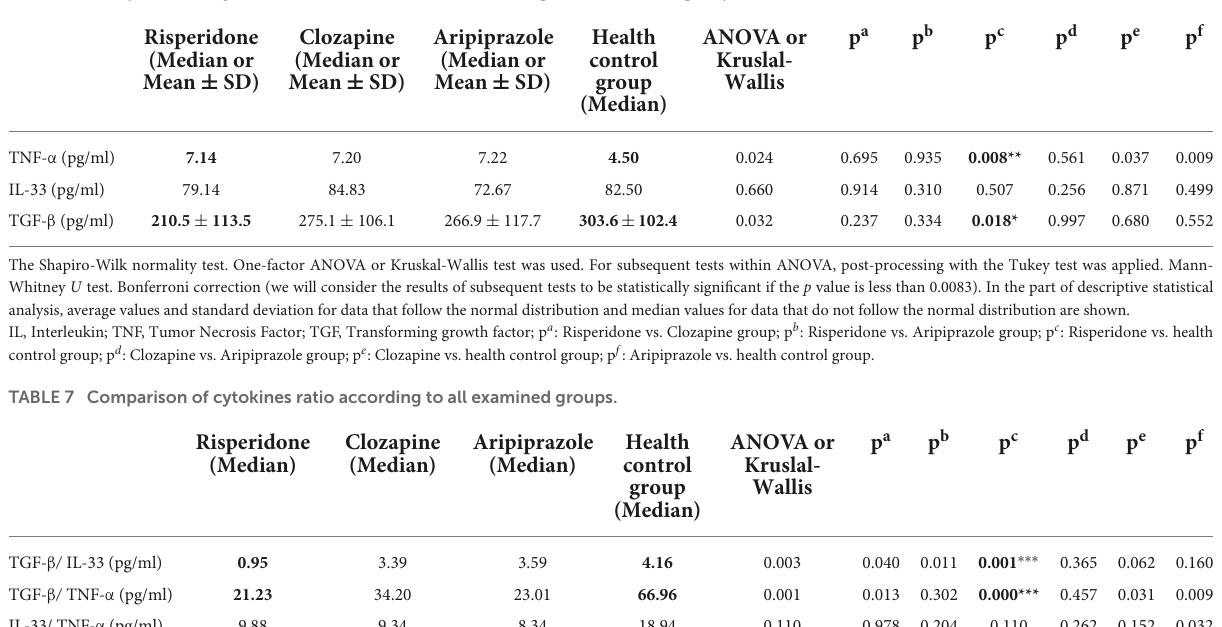
The Shapiro-Wilk normality test. Pearson’s correlation coefficient or Spearman’s correlation coefficient. Pearson’s correlation coefficient is denoted by "R" and Spearman’s correlation coefficientisdenotedby"Rho".IfRorRhois > 0.5,itmeansthatthereisapositiveandstrongcorrelation,andtheconditionforittobestatisticallysignificantisthatpis < 0.05. HDL, High density lipoprotein; LDL, Low density lipoprotein; BMI, Body Mass Index; HOMA index, Homeostatic Model Assessment for Insulin Resistance; WHR, Waist-to-hip ratio; IL,Interleukin;TNF,TumorNecrosisFactor;TGF,Transforminggrowthfactor. TABLE 6 Comparison of cytokine concentration values according to all examined groups.